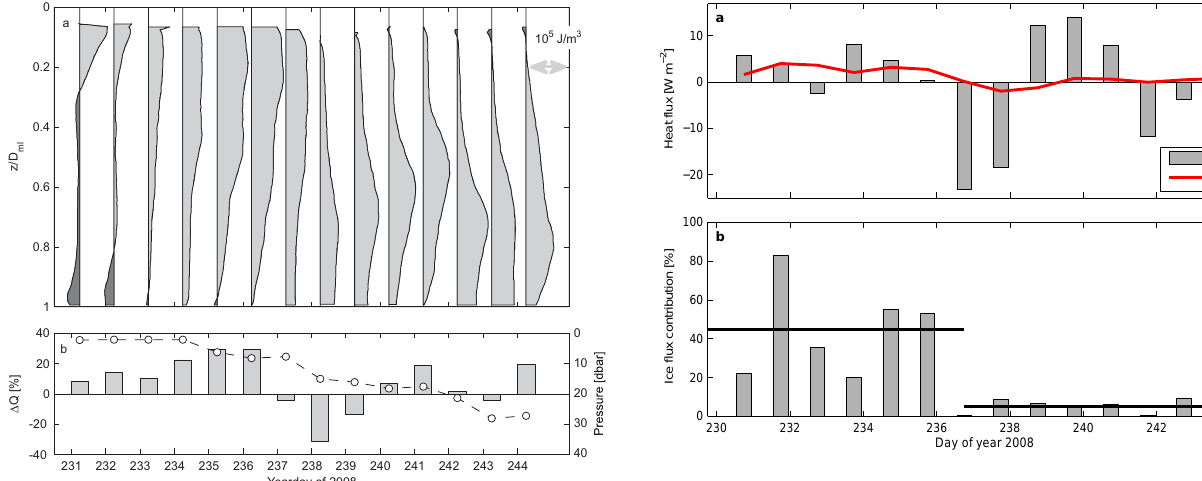
Fig. 11. (a) Difference in heat content (Jm − 3 ) for subsequent 24-h averaged profiles relative to the first profile centred at 230.25. Depth is normalized by the mixed layer depth for each profile. Light gray shading indicates heat gained from the first profile and dark gray shading indicates heat lost from the first profile. (b) Change in to- tal mixed layer heat content for average profiles relative to the first profile (bars) and the pressure ( ∼ depth) at heat content maximum, vertical axis on the right (circles).